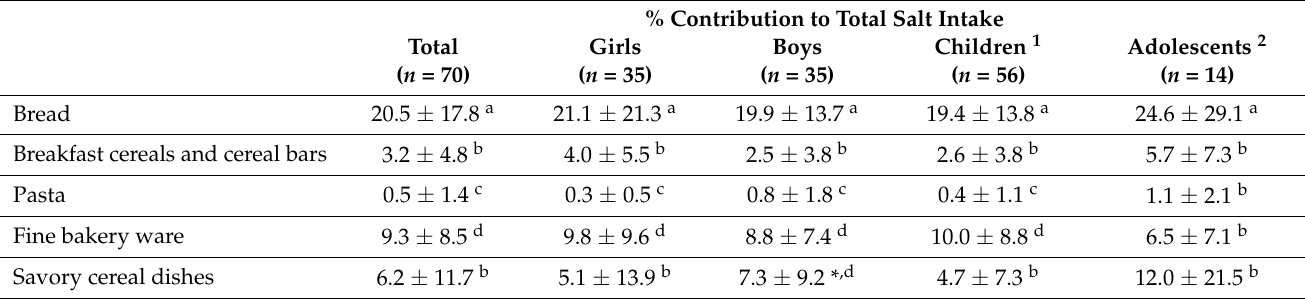
Table 9. Contribution of the different types of gluten-free products of to the daily salt intake in Spanish children and adolescents, both genders, with celiac